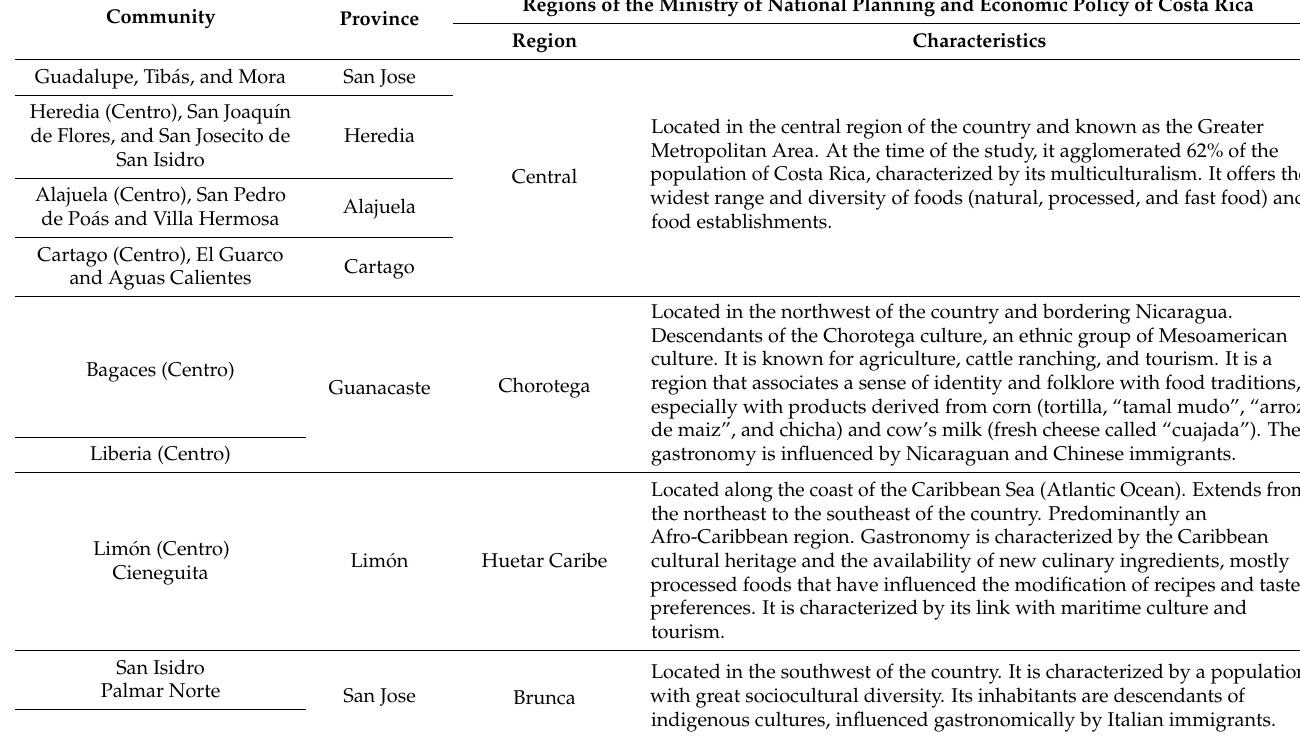
Table A1. Geographical and sociocultural characteristics related to food of the communities studied according to regions of the Ministry of National Planning and Economic Policy of Costa Rica. Community